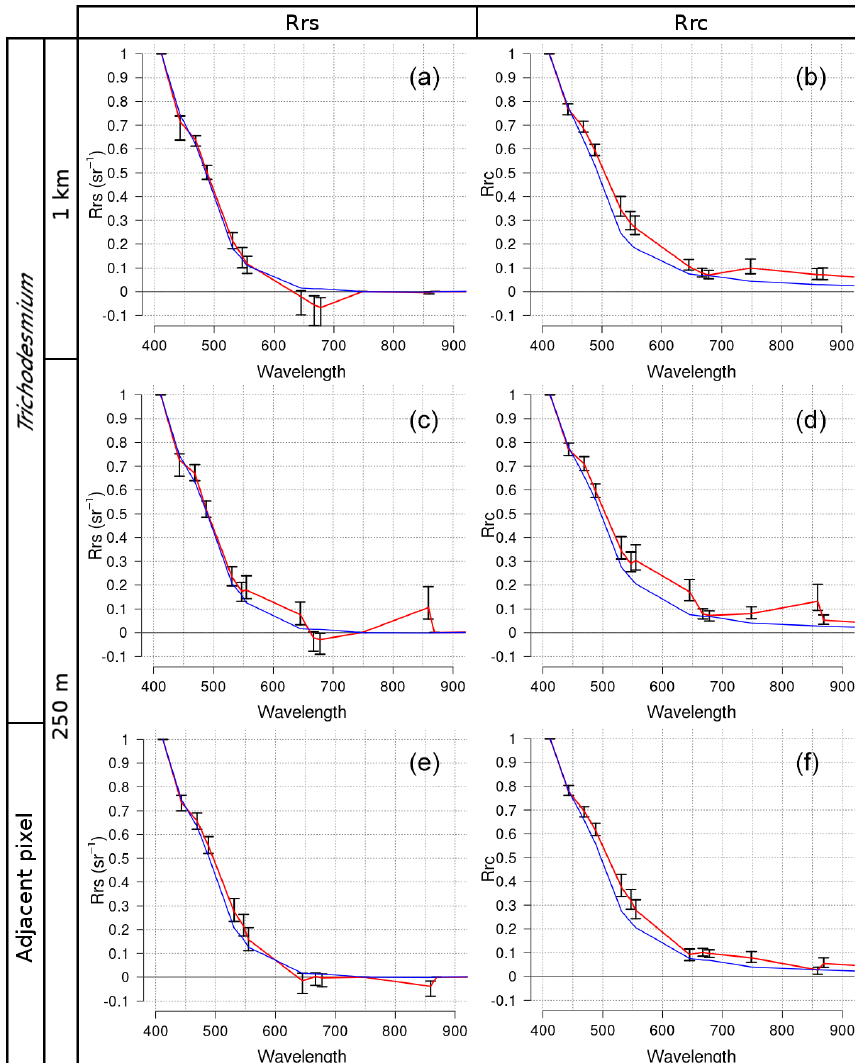
Figure 4. MODIS spectra of Trichodesmium mats (a, b, c, d) and adjacent areas (e, f) normalized by the maximum spectral value of all wavelengths, with pixel resolution at 1km (a, b) and 250m (c, d, e, f) . Panels (a) , (c) , and (e) are R rs reflectances. Panels (b) , (d) , and (f) are R rc reflectances. The average is the red line and error bars are the standard deviation. The average of the water signal is the blue